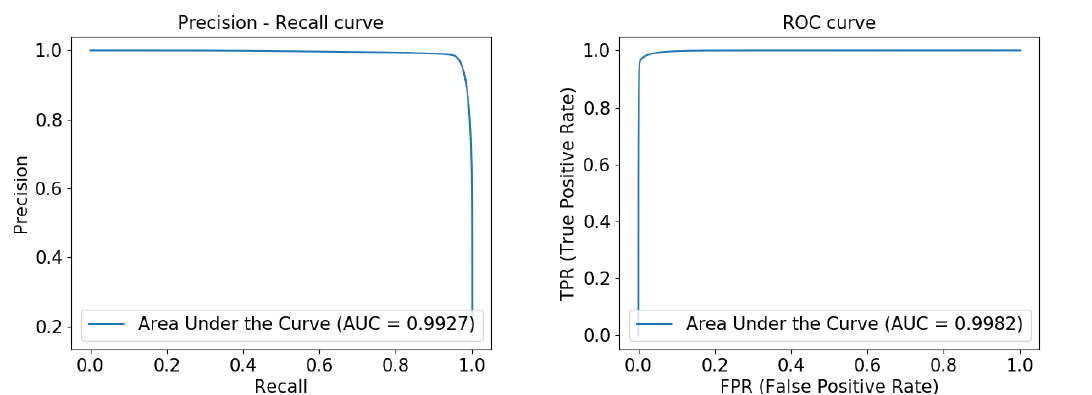
Figure 8. Precision-recall curve and ROC curve experimentally obtained from FAU-Net on the ELE data set from left to right.